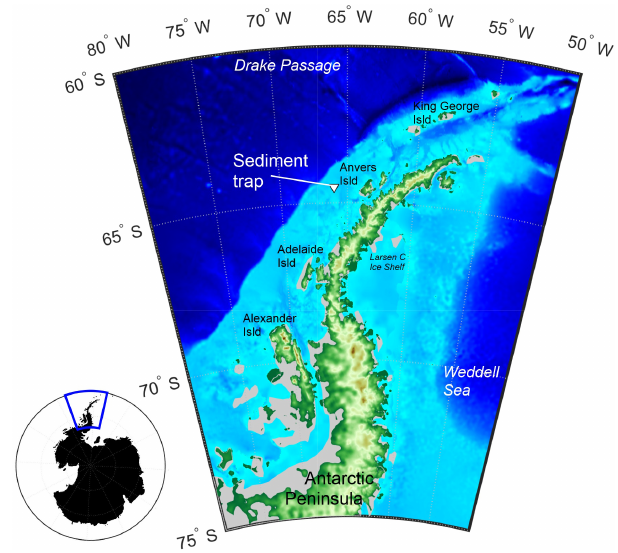
Figure 1. A map of the study area with the Palmer Long-Term Eco- logical Research programme (Palmer LTER) sediment trap loca- tion marked with the triangle. Grey regions show ice shelf regions. Main map is enlarged view of blue box and was made using etopo1